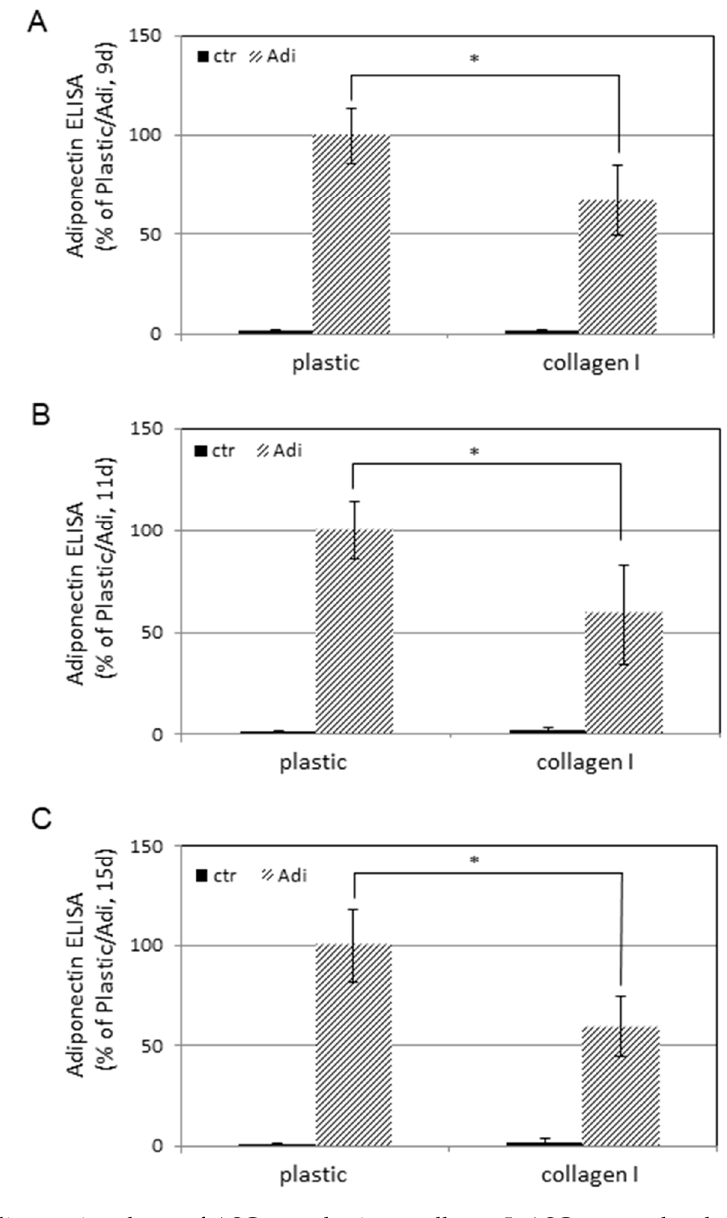
Figure 4. Adiponectin release of ASCs on plastic or collagen I. ASCs were plated at a density of 1 × 10 4 cells per well into microtiterplates either non ‐ coated (plastic) or coated with collagen I. One part was held in regular DMEM medium (ctr) and the other in adipogenic medium (Adi). After ( A ) 9 days, ( B ) 11 days, and ( C ) 15 days, supernatants were examined for adiponectin by ELISA. Each point represents the mean of 20 independent experiments. The standard deviations are indicated. Data sets of Adi/plastic and Adi/collagen I were statistically compared as indicated. * p < 0.05.